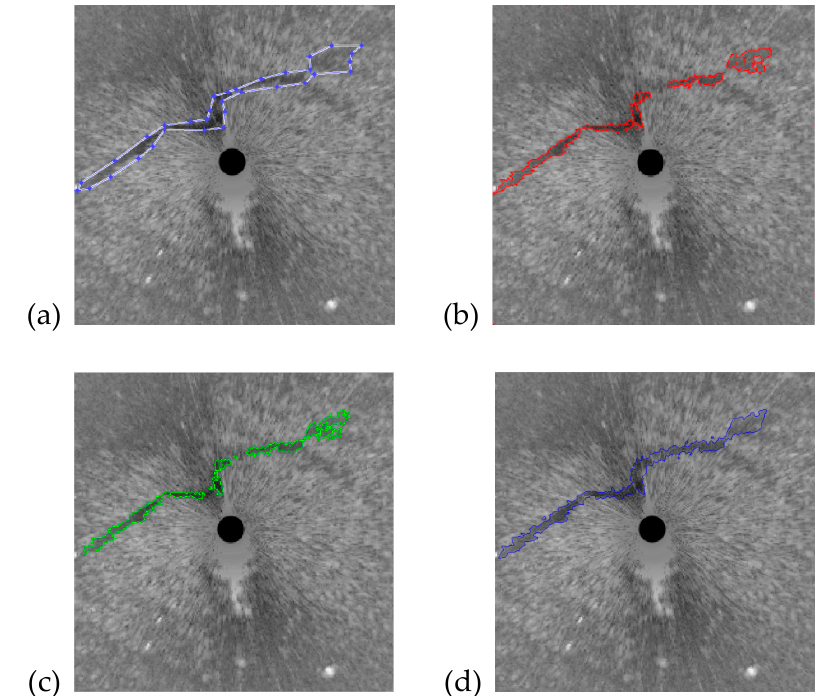
Figure 18. Sea clutter image of calm sea surface.